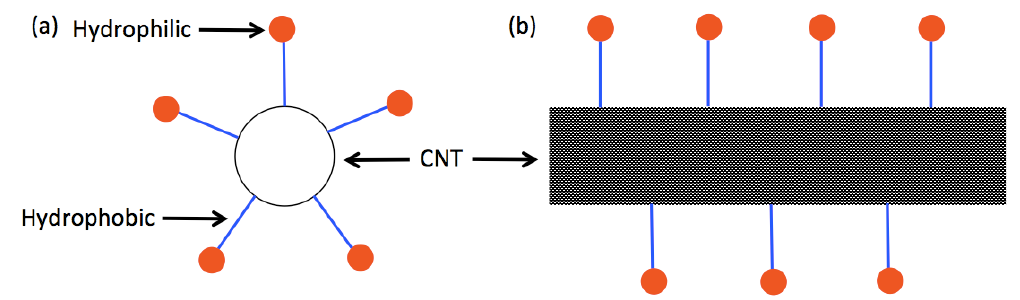
Figure 3. Surfactant-assisted dispersion of carbon nanotubes: ( a ) cross-section of carbon nanotube; and ( b ) side view of carbon